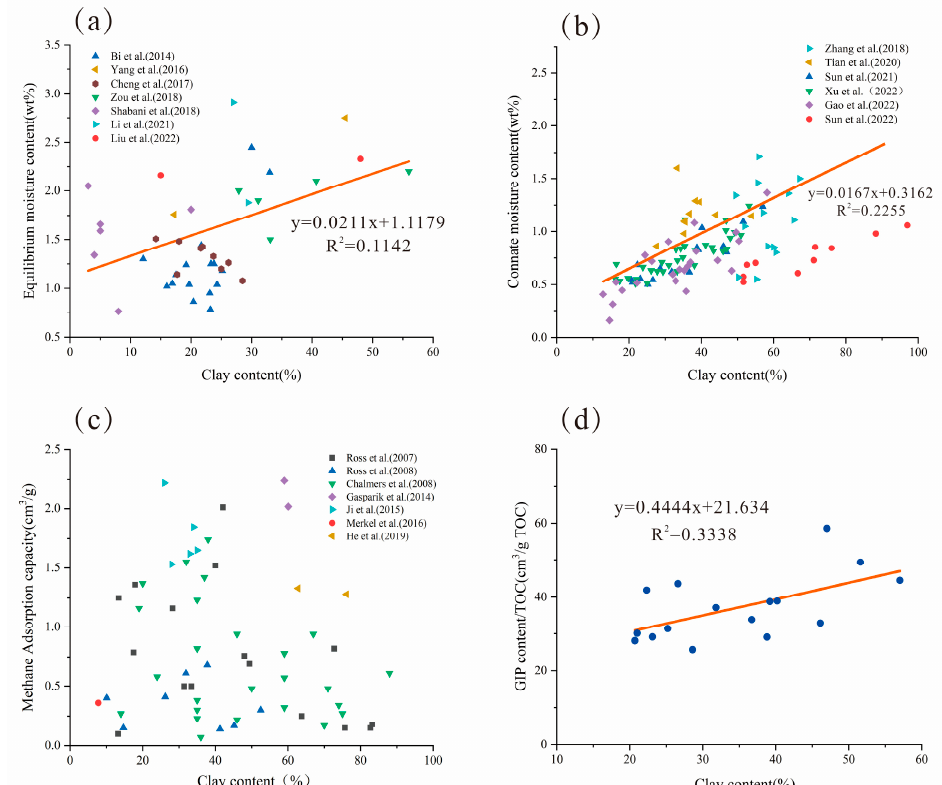
Figure 8. ( a ) Correlation between clay minerals and equilibrium moisture content. The data are from [64,74,89,91,130,185,186]. ( b ) Correlation between clay minerals and connate water content. The data are from [39,40,71,93,133,187]. ( c ) Correlation between clay minerals and methane adsorption capacities of shales containing equilibrium moisture (pressure 6Mpa, temperature 303–318 K). The data